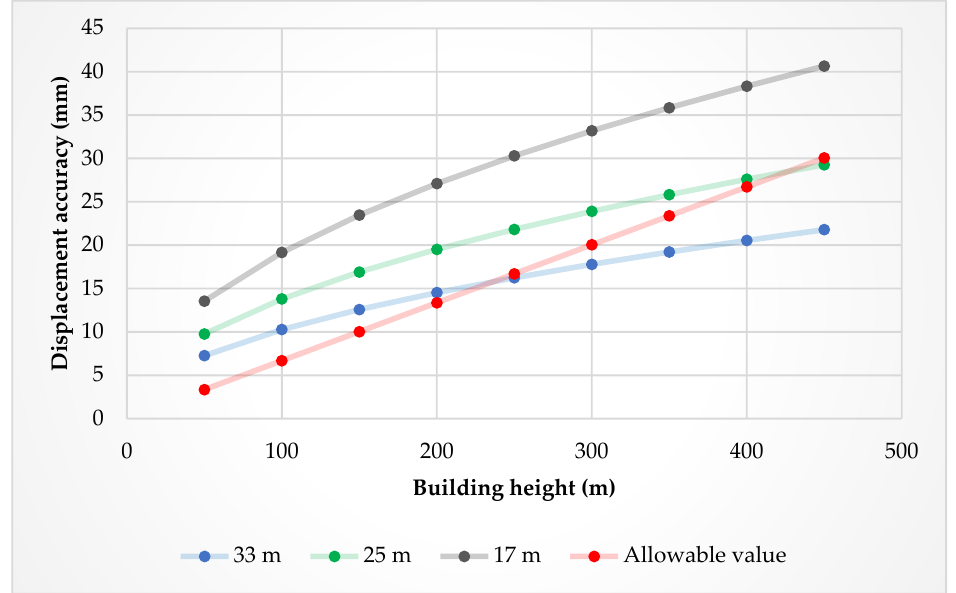
Figure 28 is a graphic summary of the results from Table 8. The horizontal axis describes a building’s height, while the vertical axis highlights the accuracy propagation.